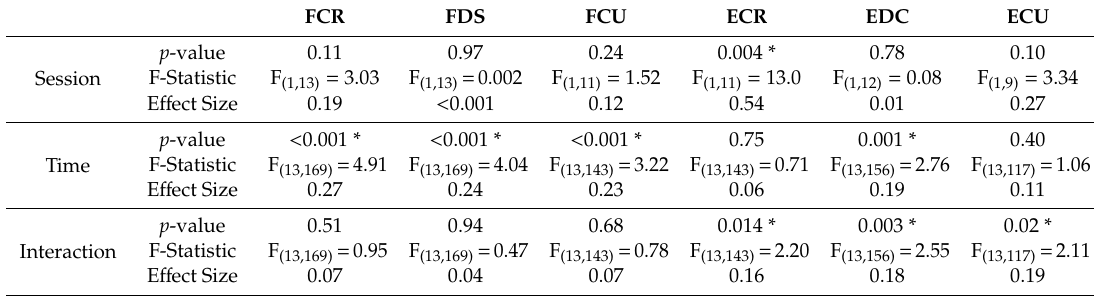
Table 2. Results from two-way repeated measures ANOVAs performed on pre-stimulus muscle activity normalized to baseline.